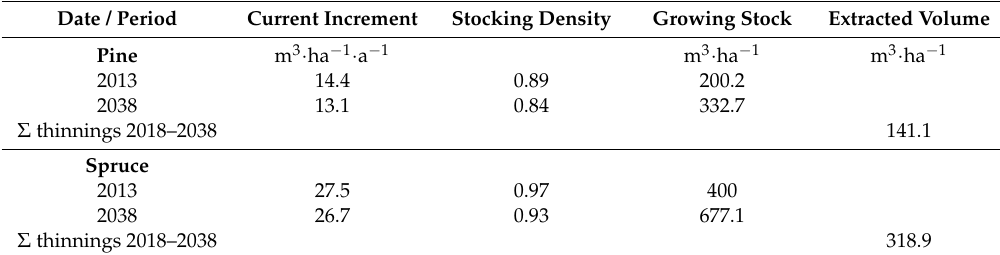
Figure 1. Development of total aboveground biomass (t ∙ ha − 1 ) of the pine and spruce stand. tGS: total growing stock, rGS: remaining growing stock after thinning. Thinning of the pine stand in 2018, 2028, and 2038; thinning of the spruce stand is carried out in 2018, 2023, 2028, 2033, and 2038. Table 3. Development of the remaining stand and sum of extracted volume in thinnings. Scots pine stand: three thinnings, Norway spruce stand: five thinnings during a 25 ‐ year period.